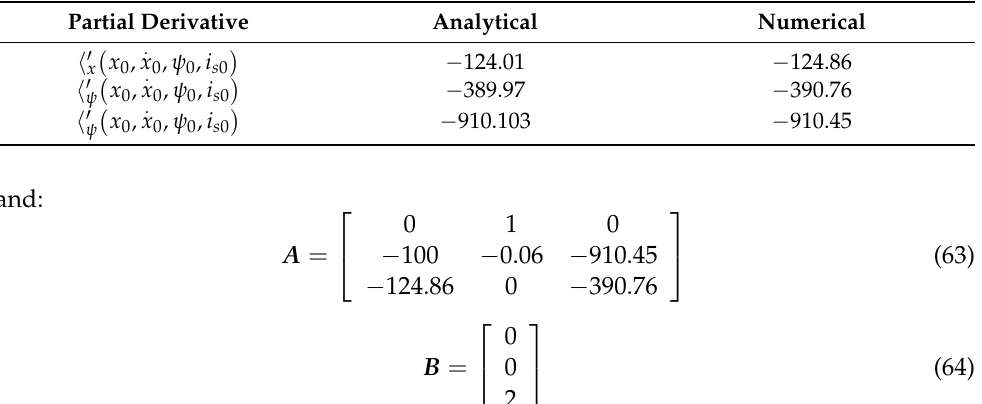
Table 1. Analytical and numerical values for the linearization partial derivatives. Partial Derivative Analytical